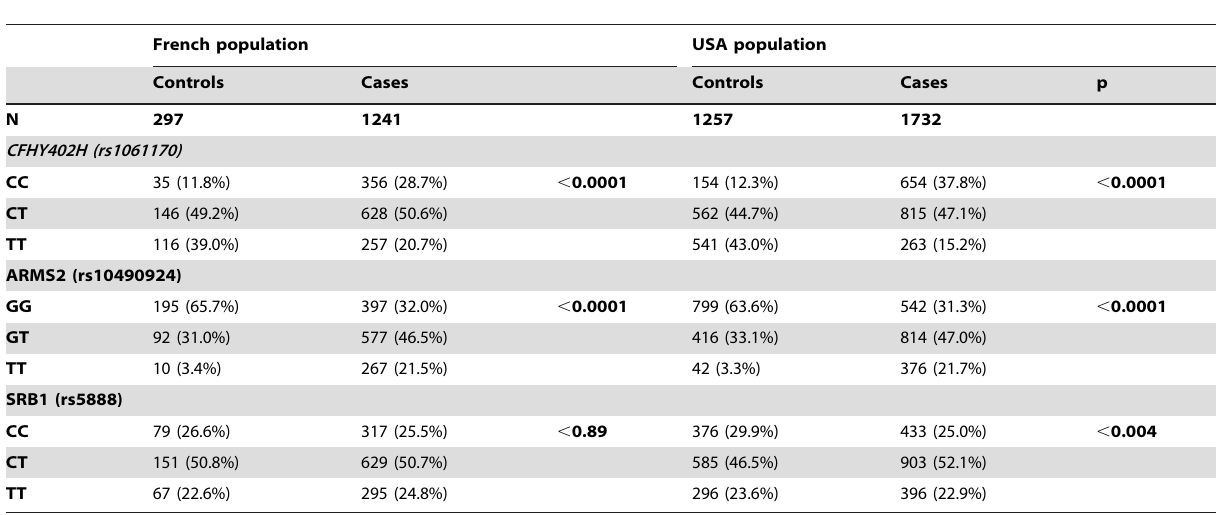
Table 2. Genotype distributions among the entire French and North American populations.